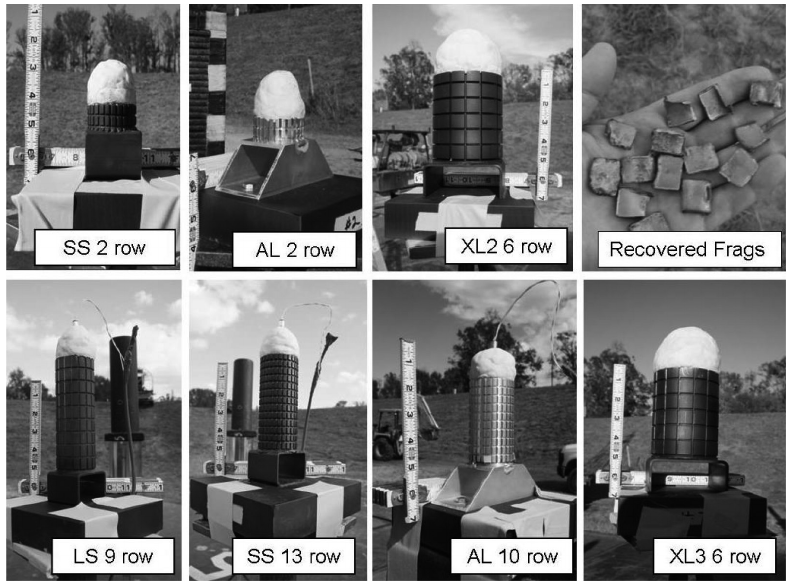
Fig. 4. Scored cased charges. Recovered XL2 fragments are